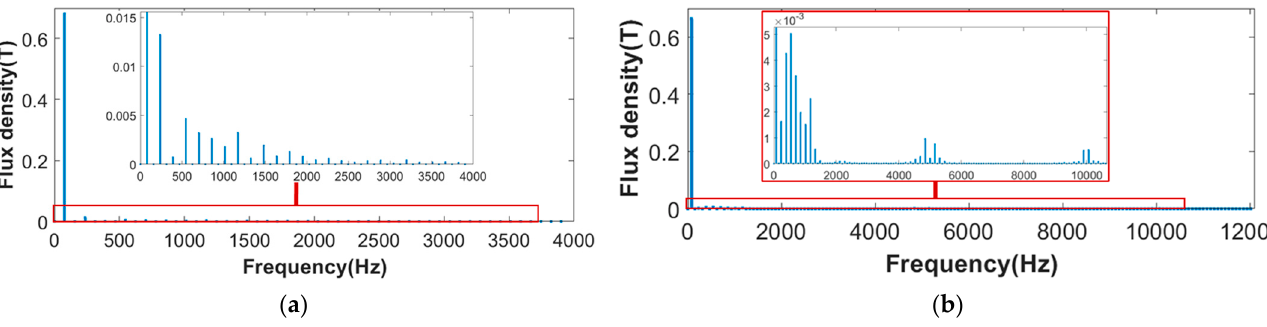
Figure 4. Spectrum of air-gap flux density: ( a ) fundamental current drive and ( b ) SVPWM drive.